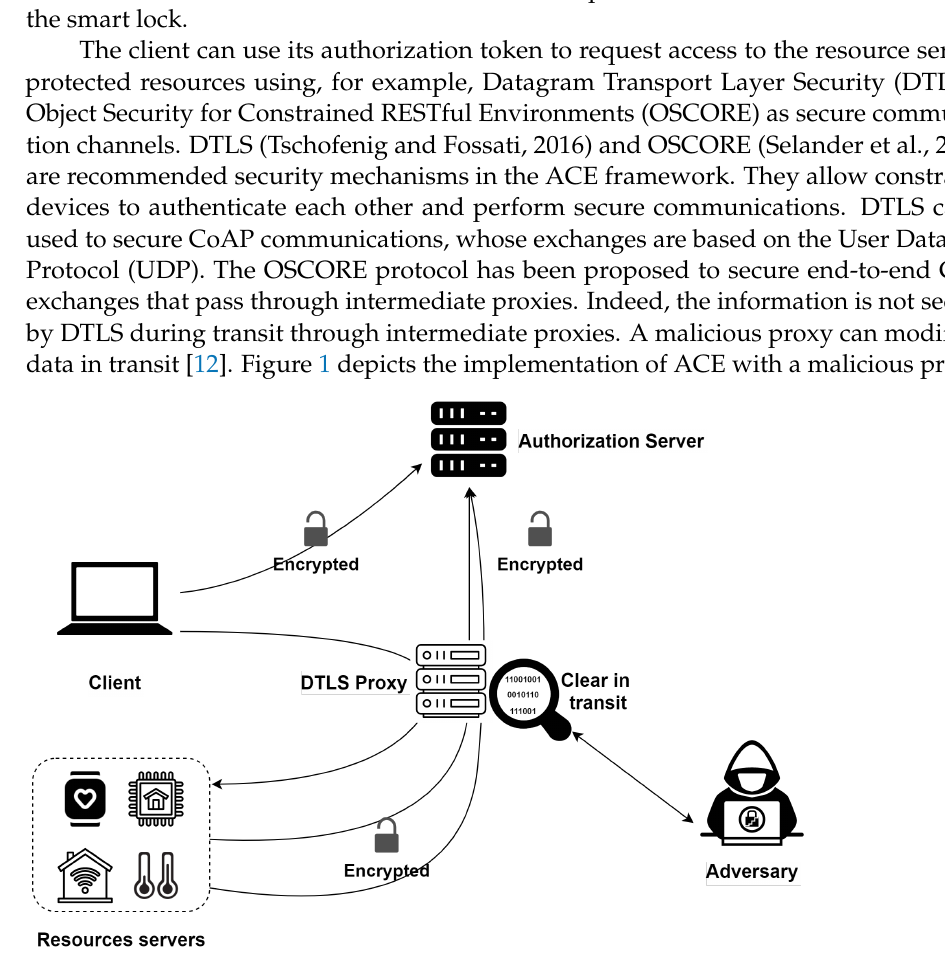
Figure 1. ACE Framework with DTLS security